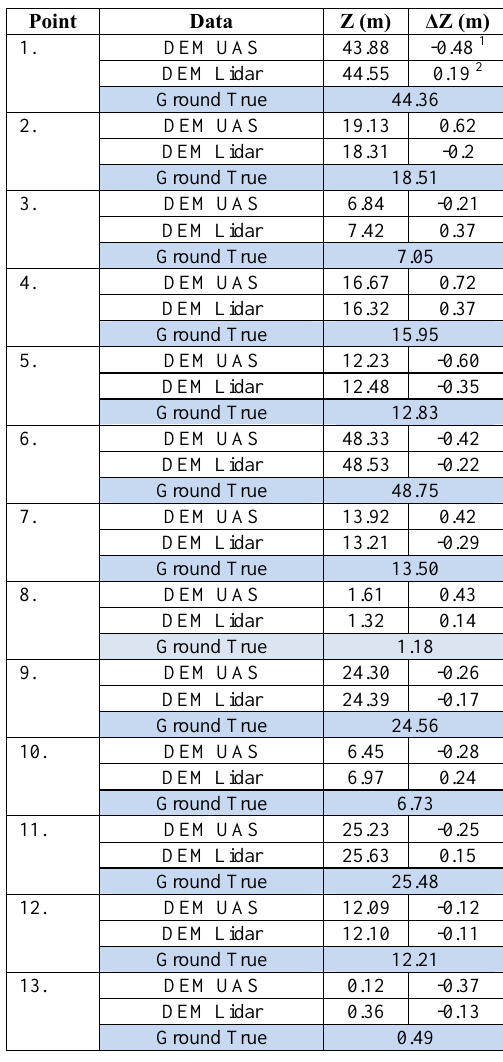
Table 1. Behaviour of Z value in both